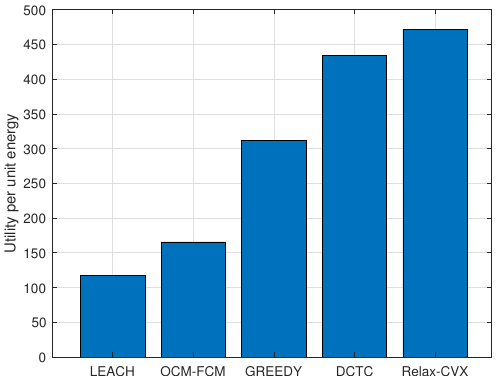
Figure 6. The utility of data collection per unit of energy consumption of different